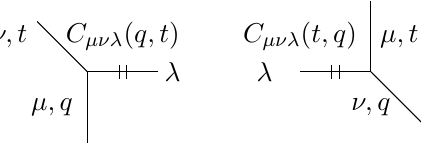
Figure 1 . Representation of the topological vertex.